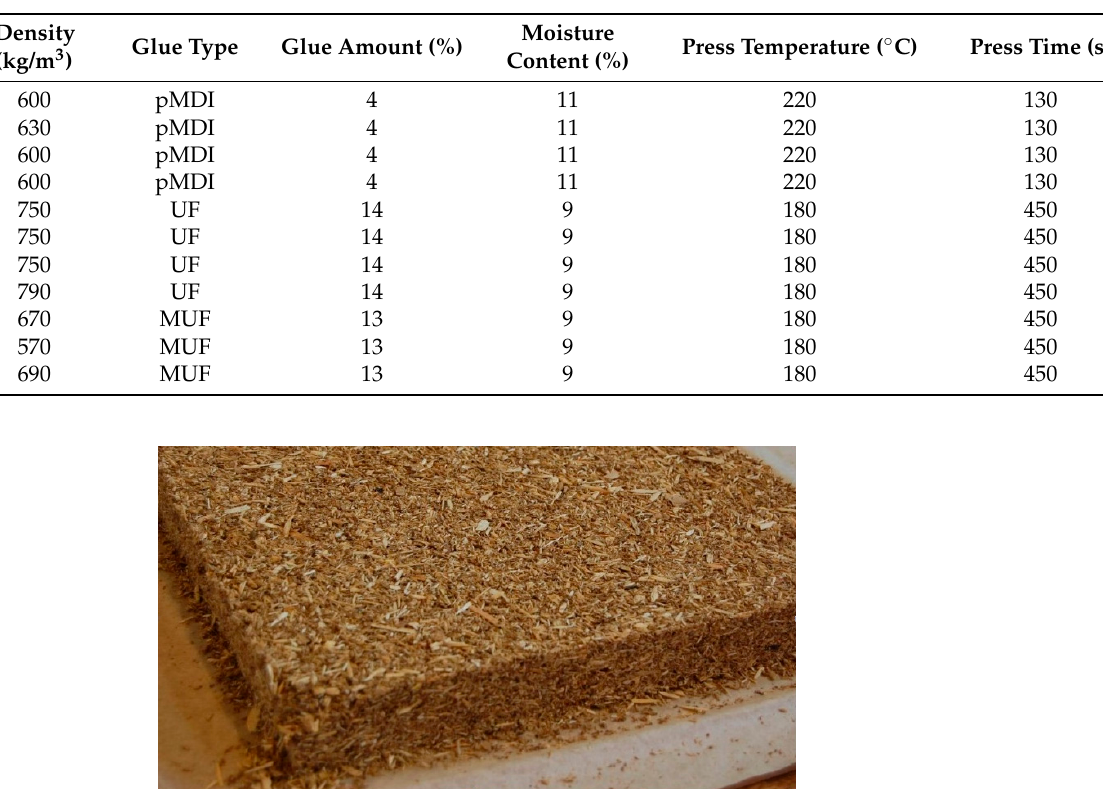
Table 1. Experimental design for the PB with BSG bonded with pMDI, MUF and UF.